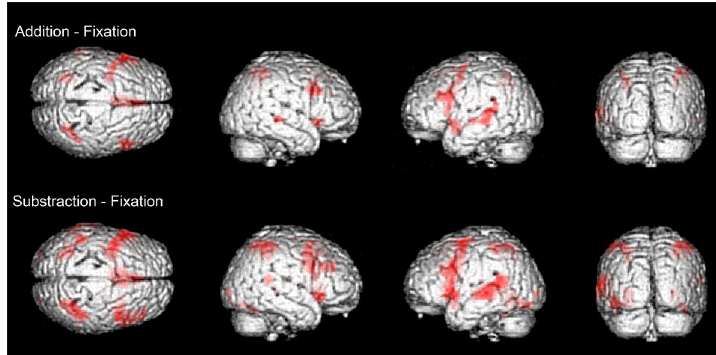
Figure 1. Addition and subtraction compared to